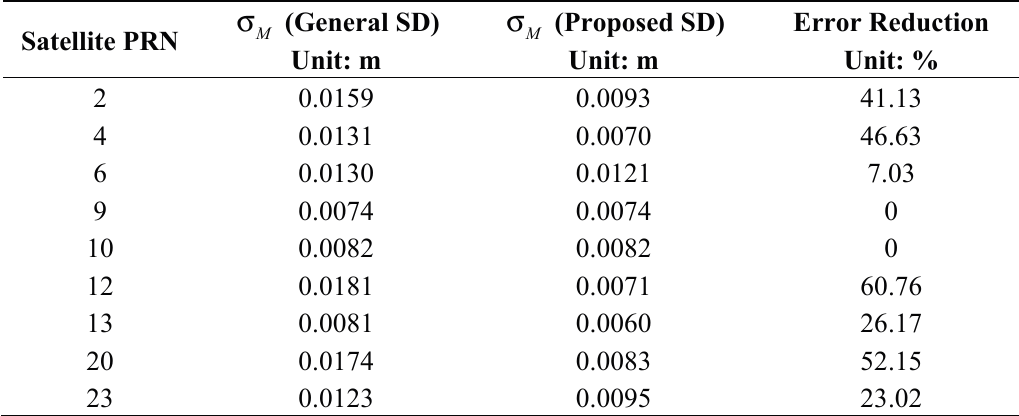
Table 3. Standard deviation of monitoring